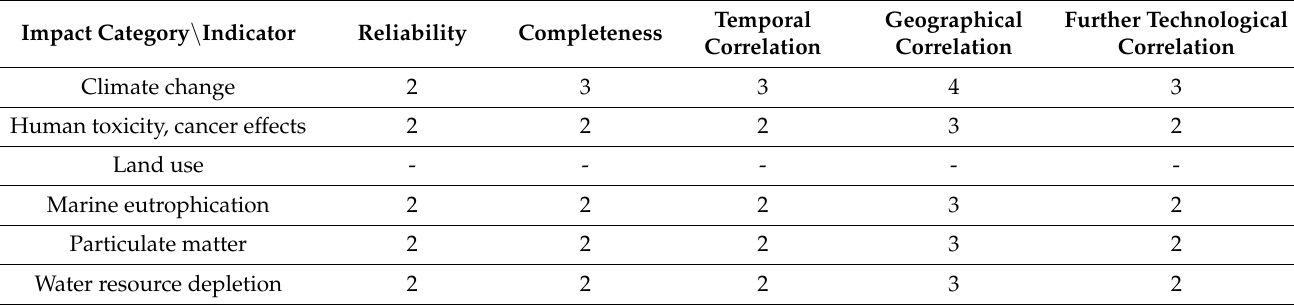
Table 6. Data quality of results.